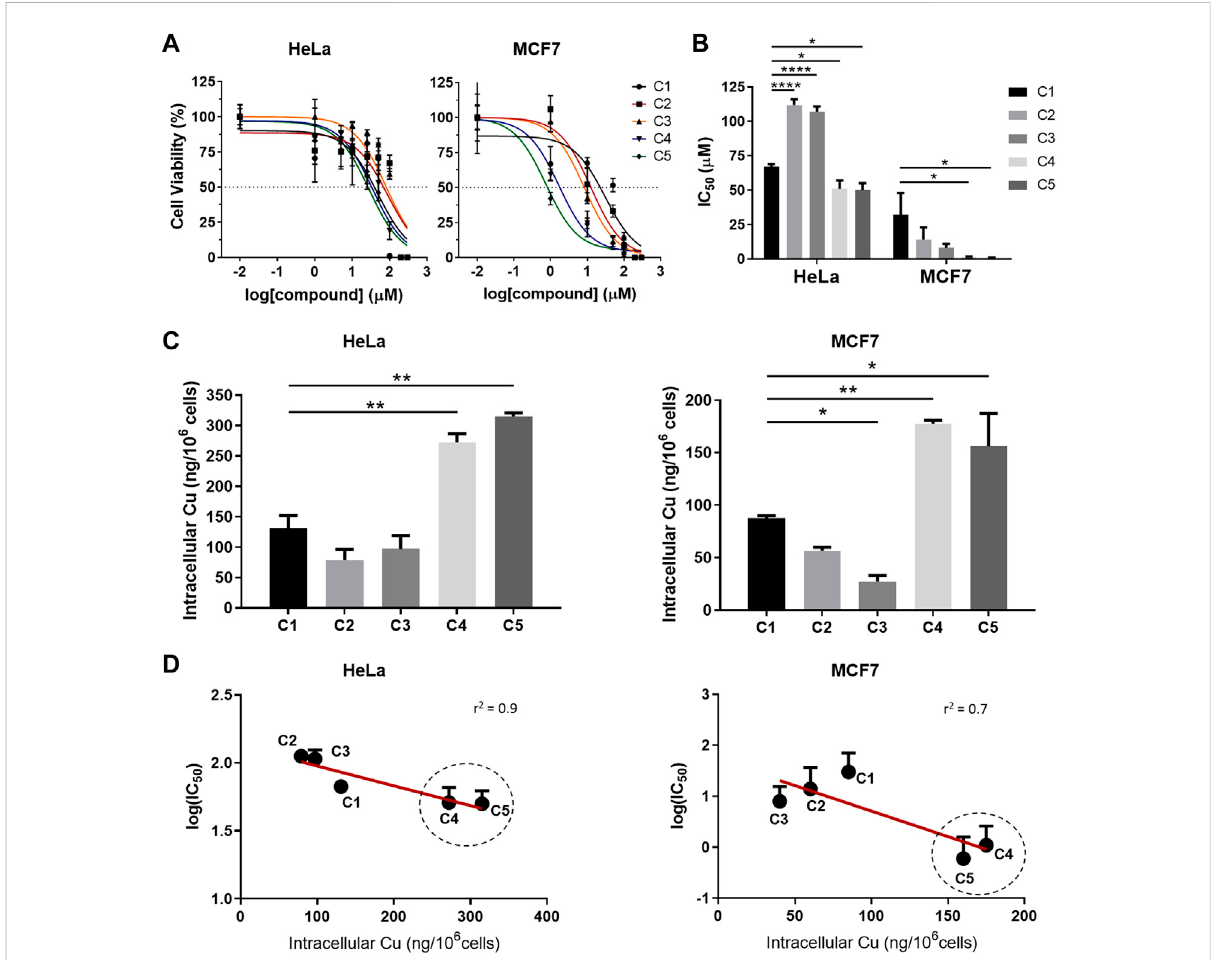
FIGURE 4 In vitro cytotoxicity and cellular internalization of C1-C5 in HeLa and MCF7 cancer cells. (A) Cell-viability assays for complexes C1-C5 in HeLa and MCF7 cancer cell lines after 24 h treatment. (B) IC 50 values for complexes C1-C5 after 24 h treatment, calculated from the corresponding cell- viability curves fi tting(Figure 4A). (C) Quanti fi cationofthecopper(Cu)uptakeinHeLaandMCF7cell linesafter 4 htreatmentwith complexesC1-C5 (50 µM). (D) Correlation between the cytotoxicity (log (IC 50 )) and the Cu uptake for HeLa and MCF7, with the cell-penetrating peptide-bearing Cu(II) complexes circled. Concentrations of the complexes are normalized in all cases based on Cu concentration for comparison purposes. Statistical differences were determined using a one-way ANOVA test, with p values as: without symbol ( p > 0.05, non-signi fi cant), * p ≤ 0.05, ** p